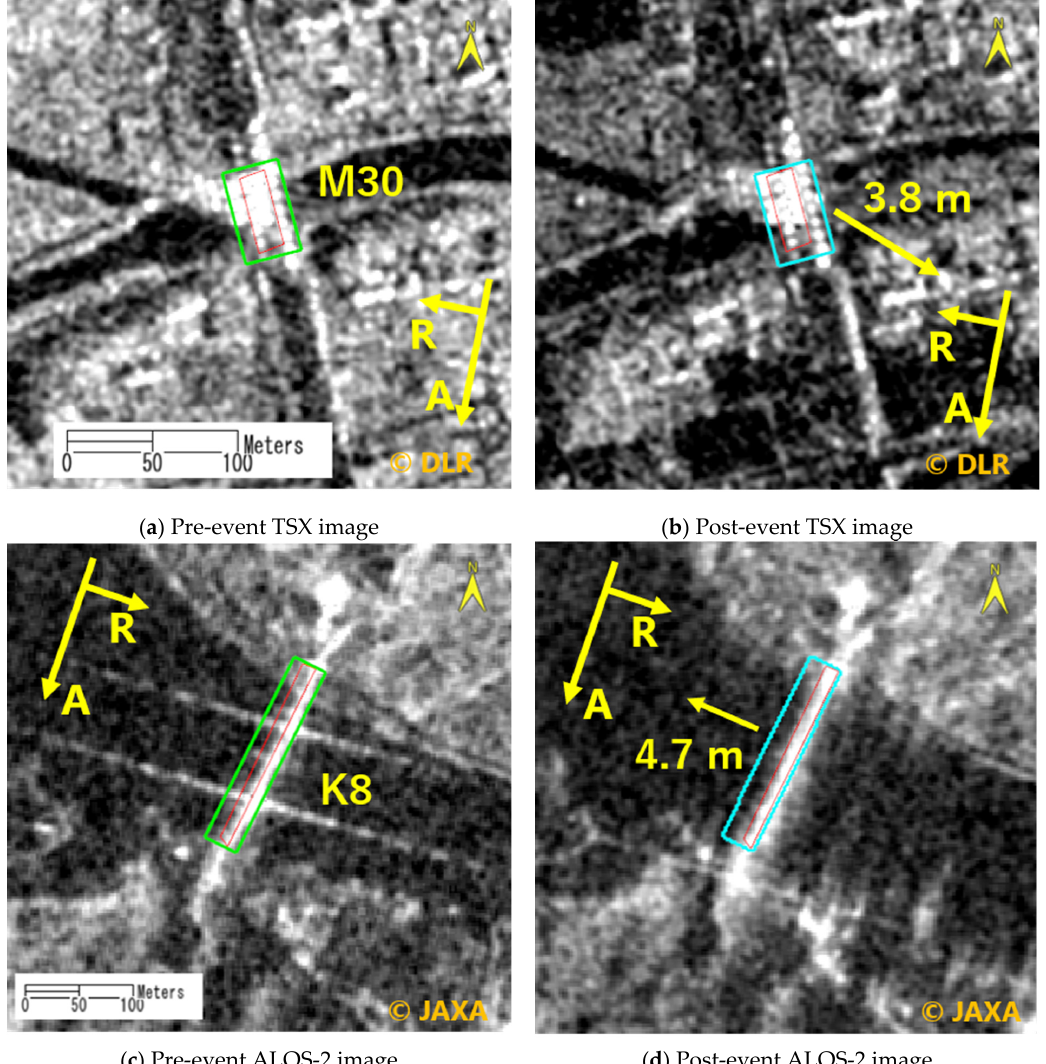
Figure 4. Two examples of the original outline (red frame), the expanded outline (green frame), and the shifted outline (cyan frame) of the undamaged bridges: ( a , b ) bridge no. M30, with 3.8 m movement to the southeast direction due to an earthquake; and ( c , d ) bridge no. K8, with 4.7 m movement in the sensor direction due to a water level rise.